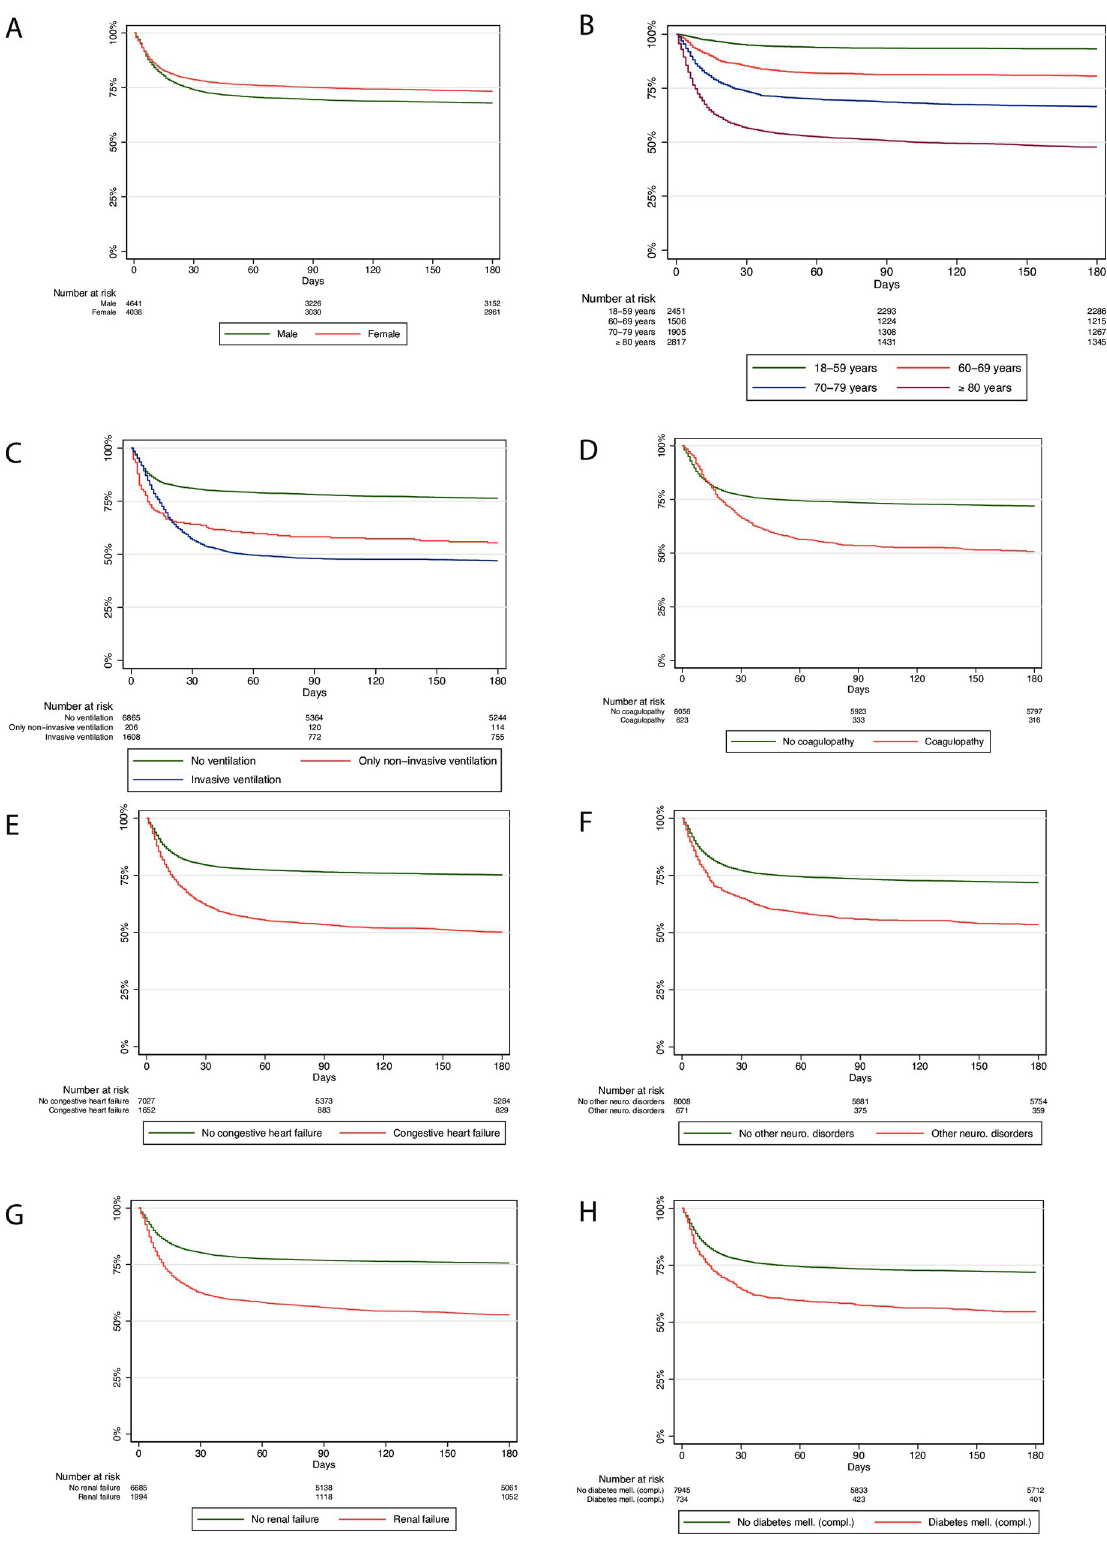
Fig 2. Kaplan-Meier survival curves of all hospitalized COVID-19 patients followed for 180 days after hospital admission.